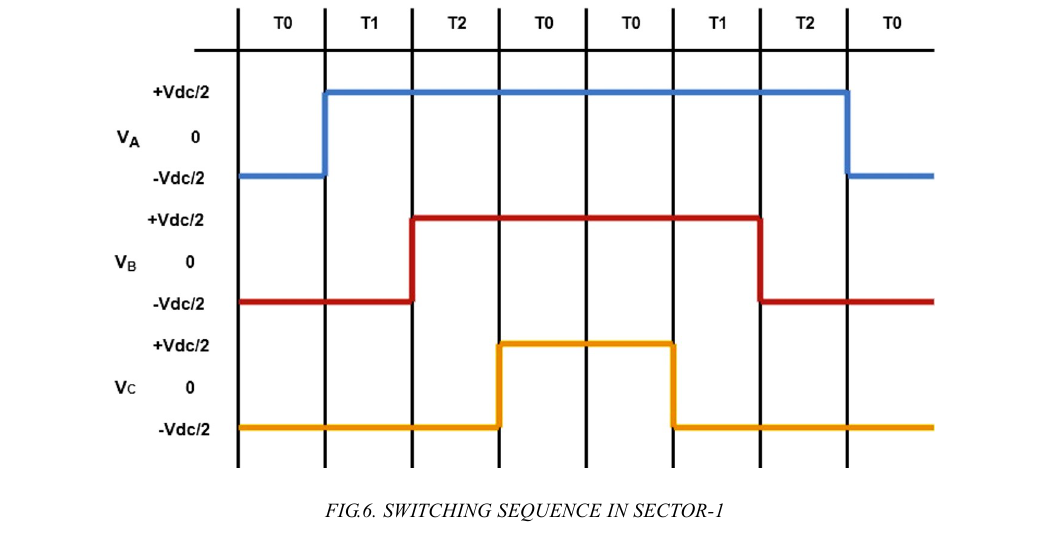
FIG.6. SWITCHING SEQUENCE IN SECTOR-1